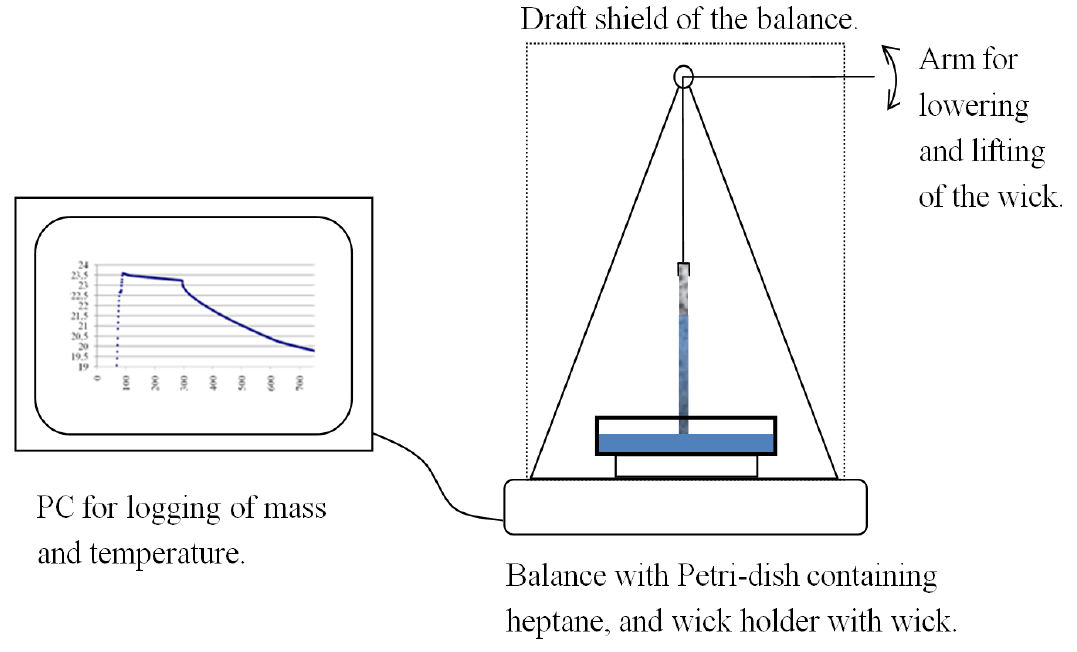
Figure 2. The rate-of-rise